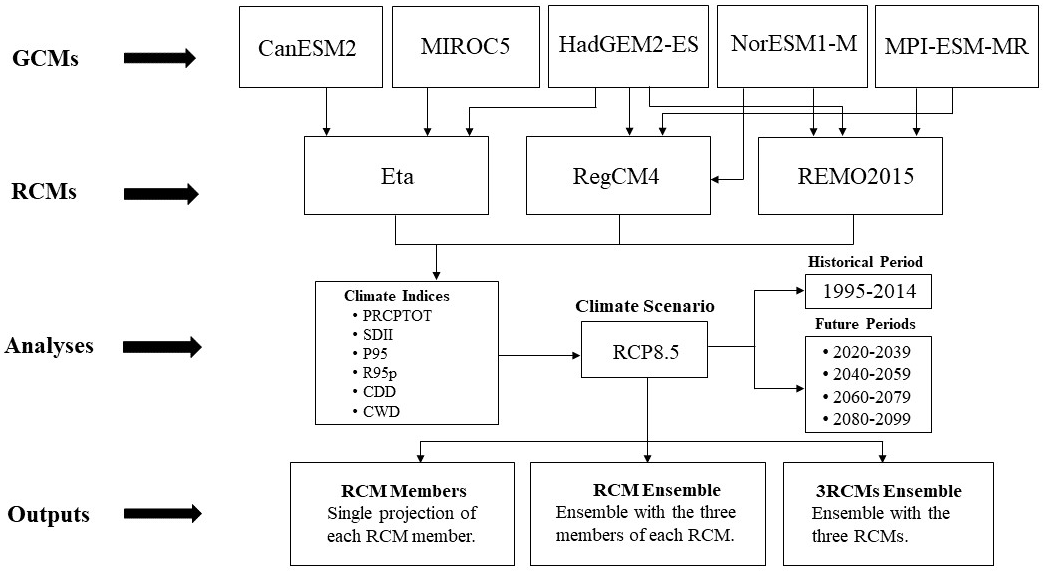
Figure 2. Flowchart describing the methodology